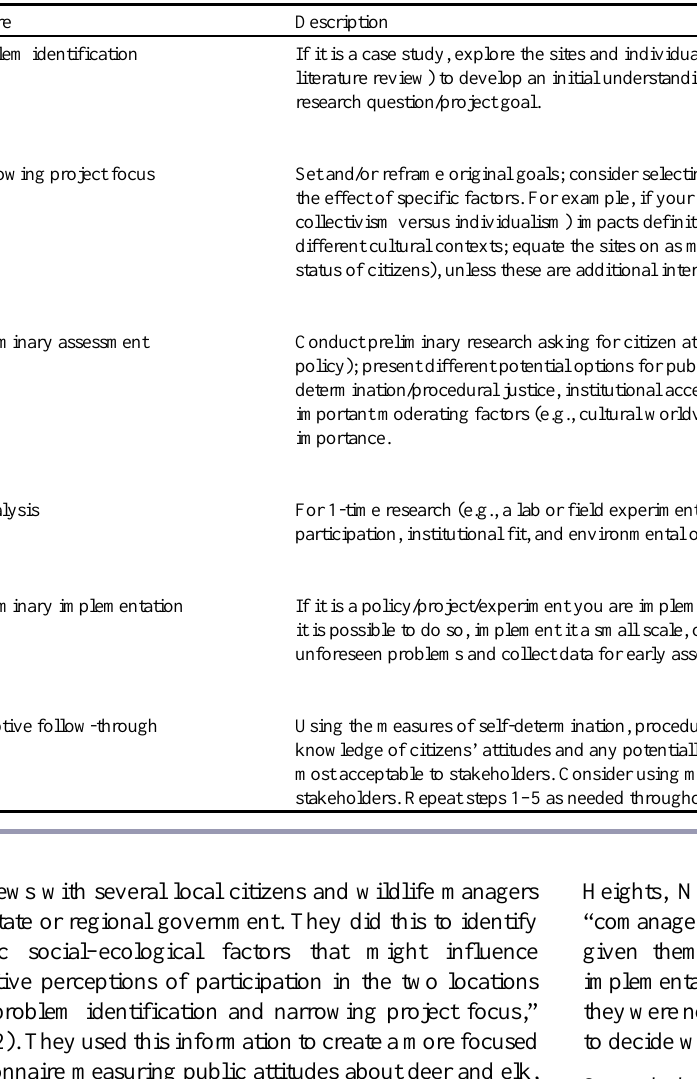
2). Approximately 400